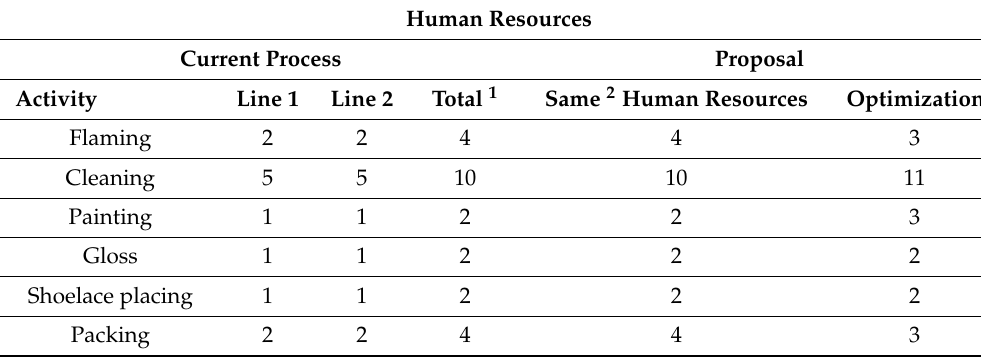
Table 7. Comparison of human resource use per day Current-Proposal-Optimization.